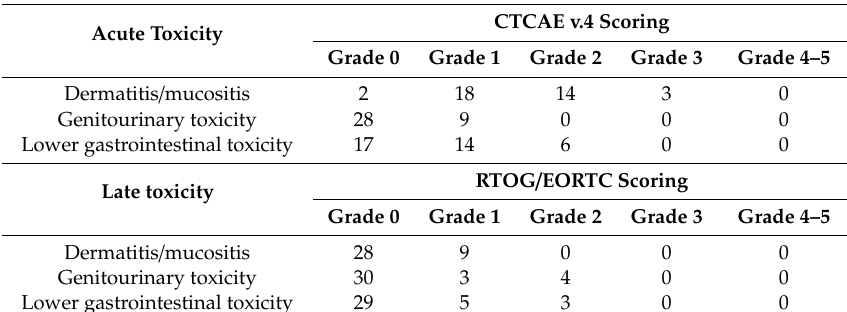
Table 3. Acute and late toxicities ( n =